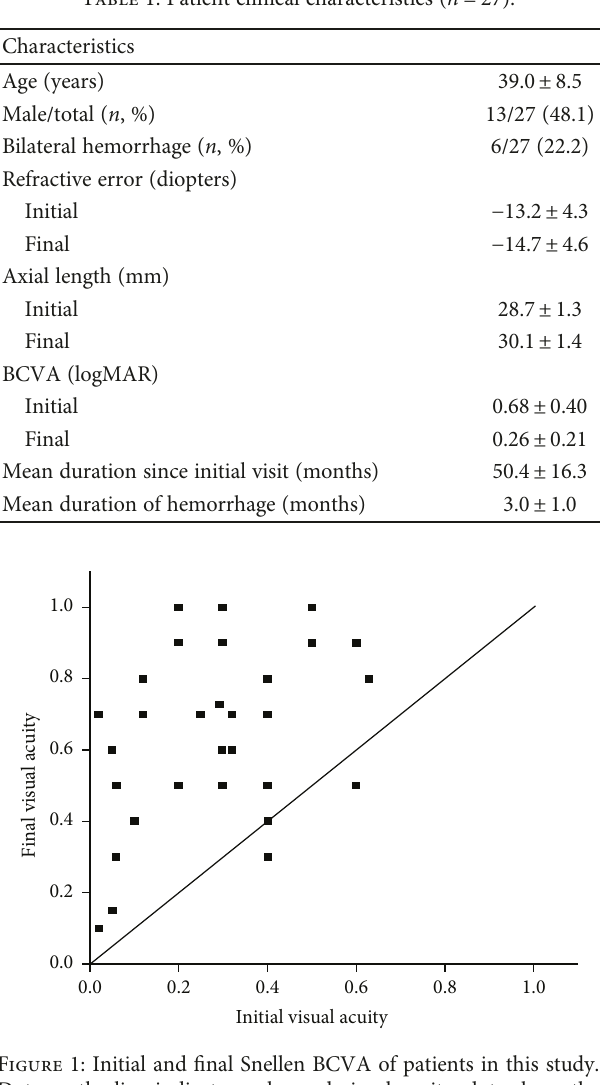
Figure 1: Initial and fi nal Snellen BCVA of patients in this study. Dots on the line indicate unchanged visual acuity, dots above the line indicate improved visual acuity, and dots below the line indicate worse visual acuity.